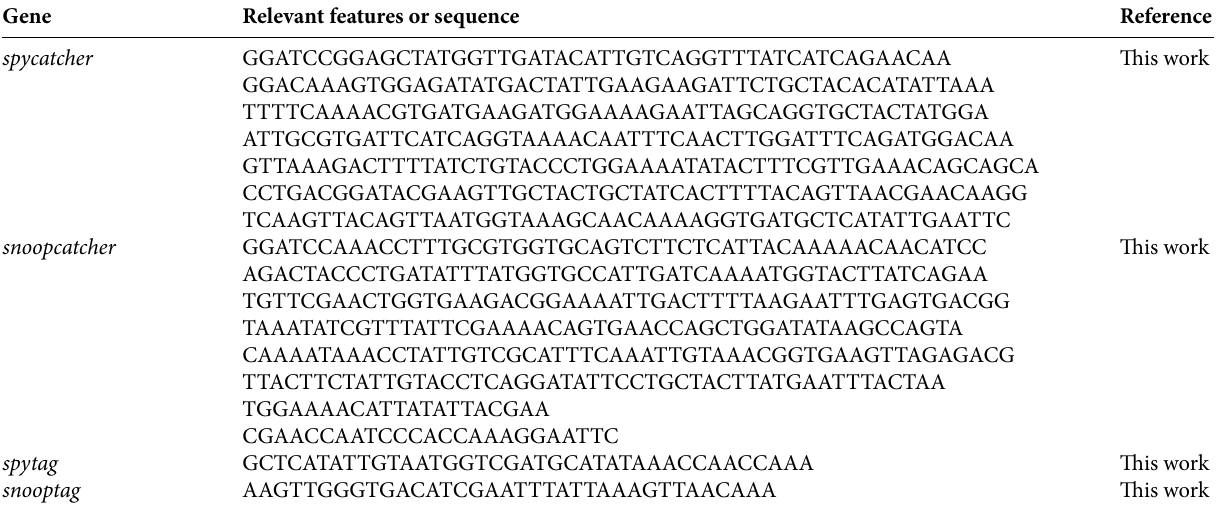
Table 4. Genes used in this